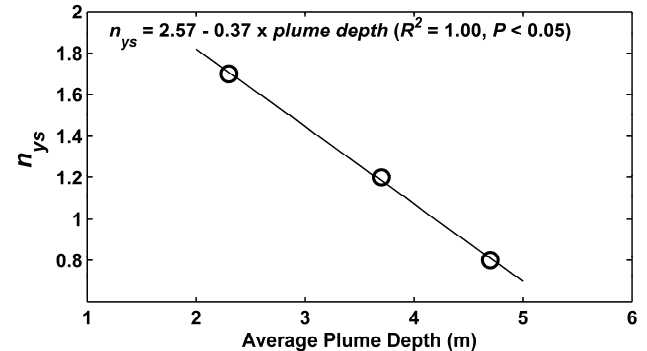
for surveys I, II and VII (Table 3a), against average Figure 6. Scatter plot of slope n ys plume depth during these surveys. The continuous line and the equation show the result of a reduced major axis regression between plume depth and n ys